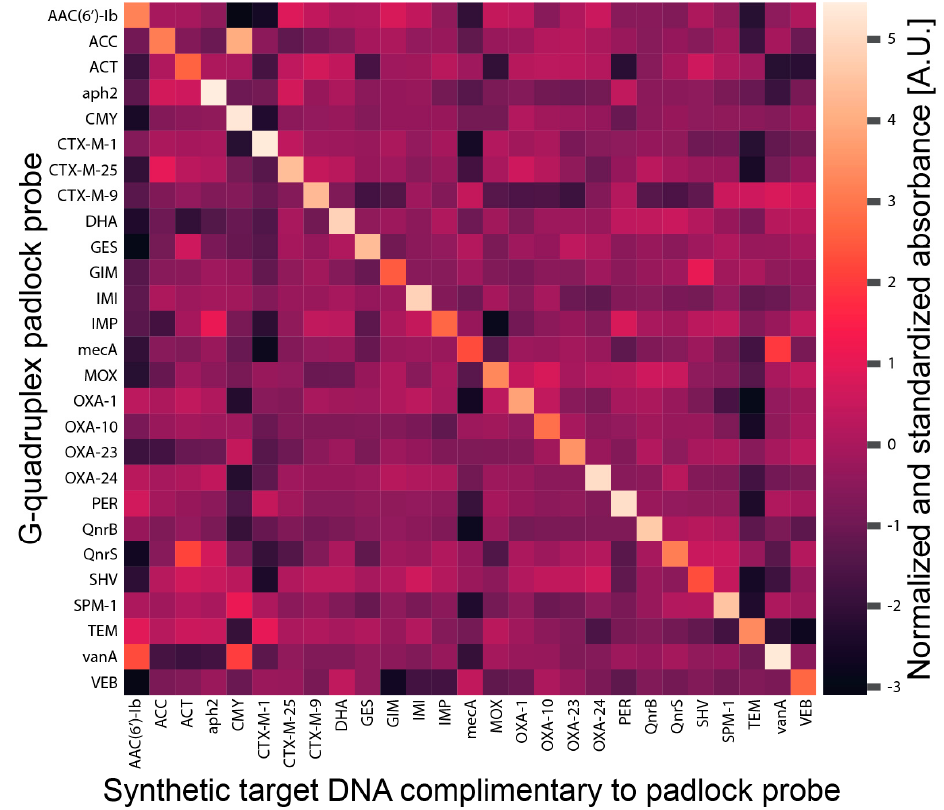
Figure 4. Specificity evaluation of 27 padlock probes targeting antibiotic resistance genes with synthetic DNA. Each target sequence was tested against all 27 padlock probes. The padlock probes were ligated, amplified, and finally, the conversion of the ABTS chromophore by the G-quadruplex DNAzymes was